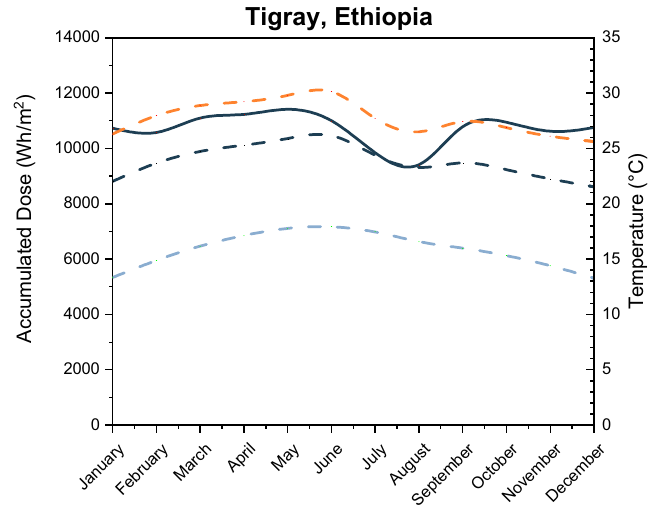
Figure 2. Accumulated global dose of solar light in the Tigray region along the year (solid line: accumulated global dose, dash lines: maximum (orange), average (black) and minimum (blue) temperatures).